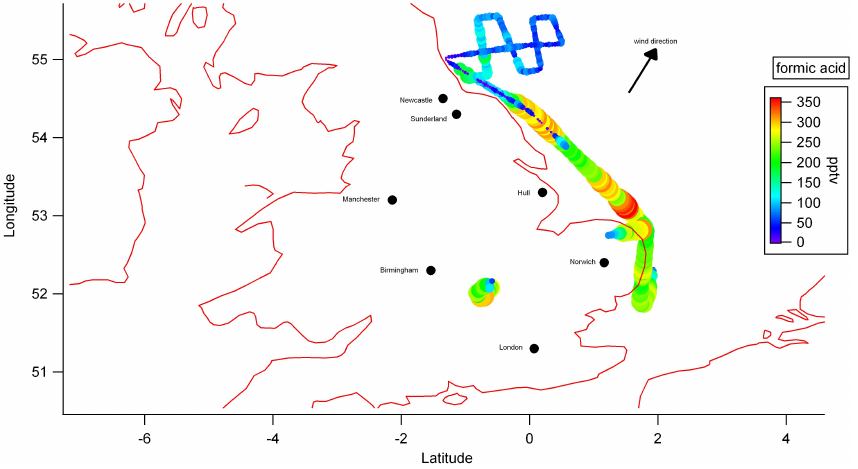
Fig. 5. The FAAM BAe-146 flight track on 16 March 2010 over the UK. Formic acid mixing ratios are reverse rainbow colour coded from 0ppb to 0.36ppb. Populated urban areas are indicated and labelled.